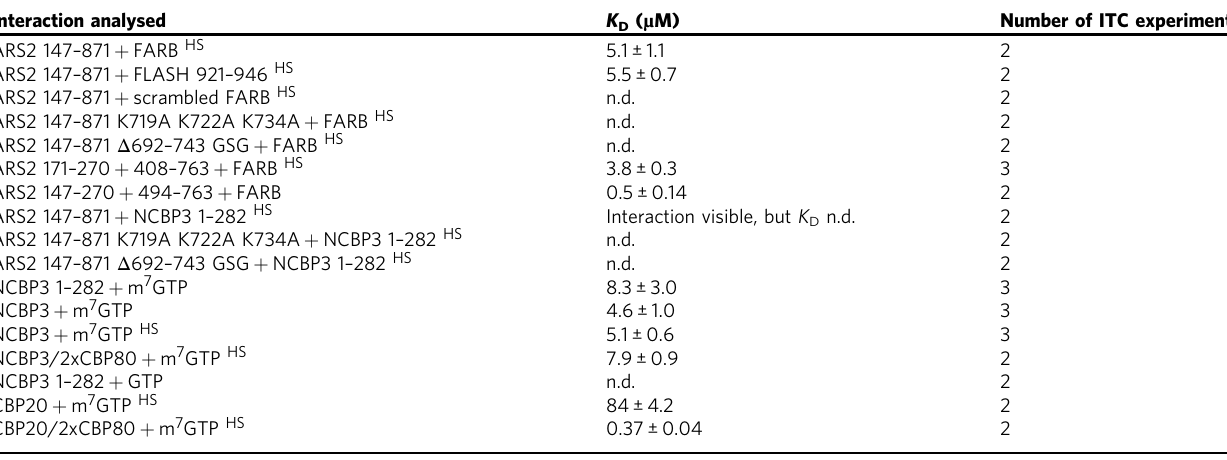
Table 2 Summary of dissociation constants measured by ITC Interaction